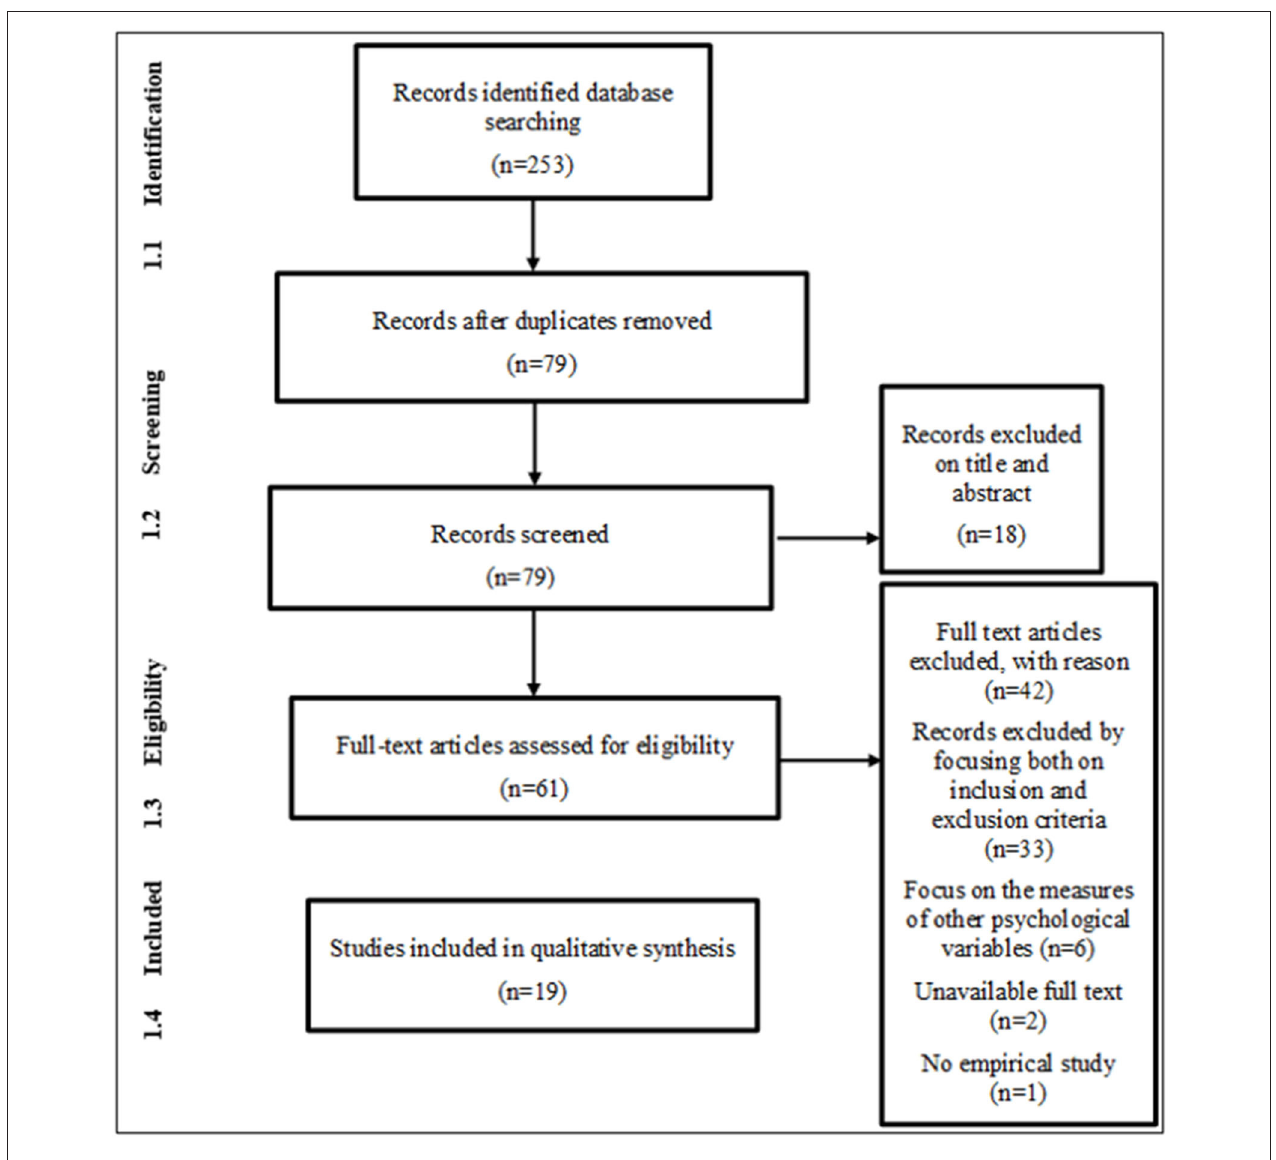
FIGURE 1 | Flowchart of the